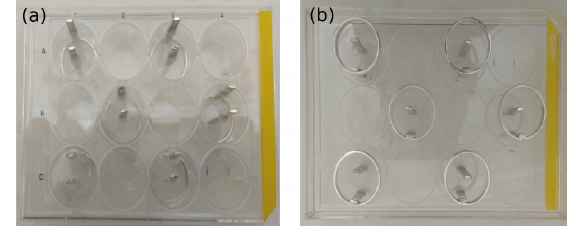
Figure 1: (a) Overhead view of the electrodes. (b) In- verted view of the